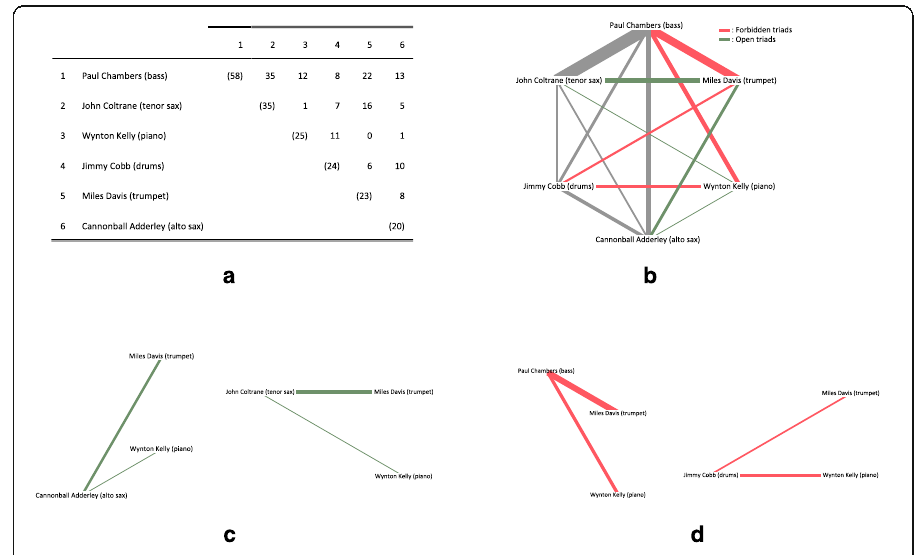
Fig. 2 Collaboration graph in the example session of “ Kind of Blue ” , March 2, 1959. a Musician co-plays ( diagonals are total plays), b graph of co-plays, c open triads, d forbidden